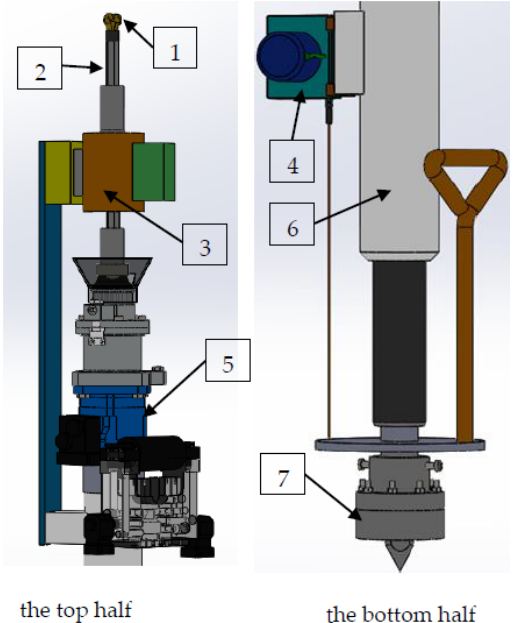
Figure 4. The three-dimensional structure diagram of the UCS detector of roadway rock. 1. PDC bit, 2. Drill pipe, 3. Torque and speed integrated sensor, 4. Pull rope displacement sensor, 5. pneumatic motor, 6. Pneumatic leg, 7. Force sensor.